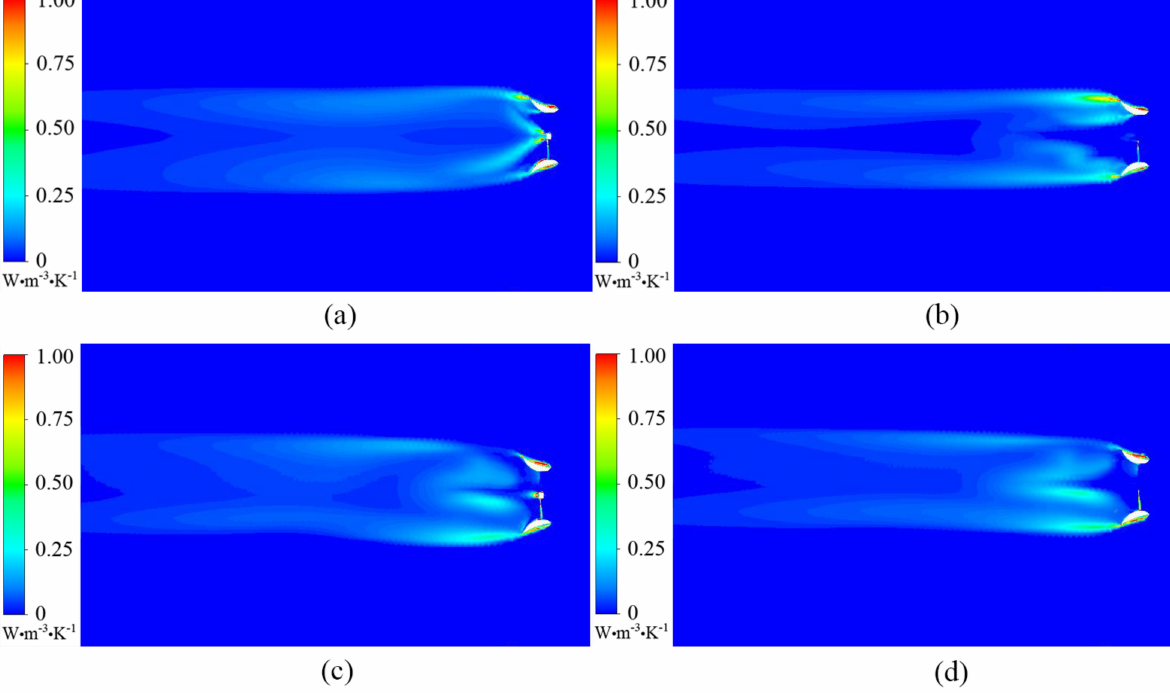
Figure 12. Total entropy production rate distribution comparison between the DT and the SDT: ( a ) DT at TSR = 4.0; ( b ) SDT at TSR = 4.0; ( c ) DT at TSR = 6.0; ( d ) SDT at TSR =